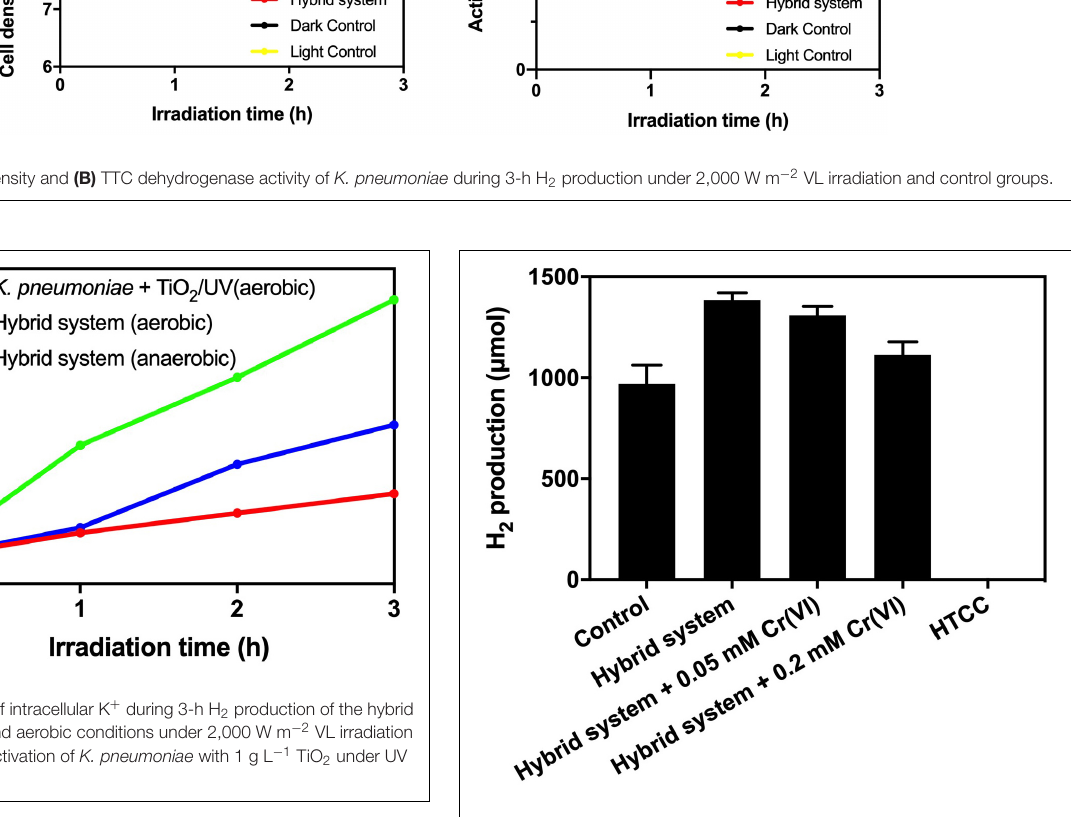
FIGURE 7 | Result of electron scavenger study of the hybrid system under 2,000 W m − 2 VL in irradiation 3